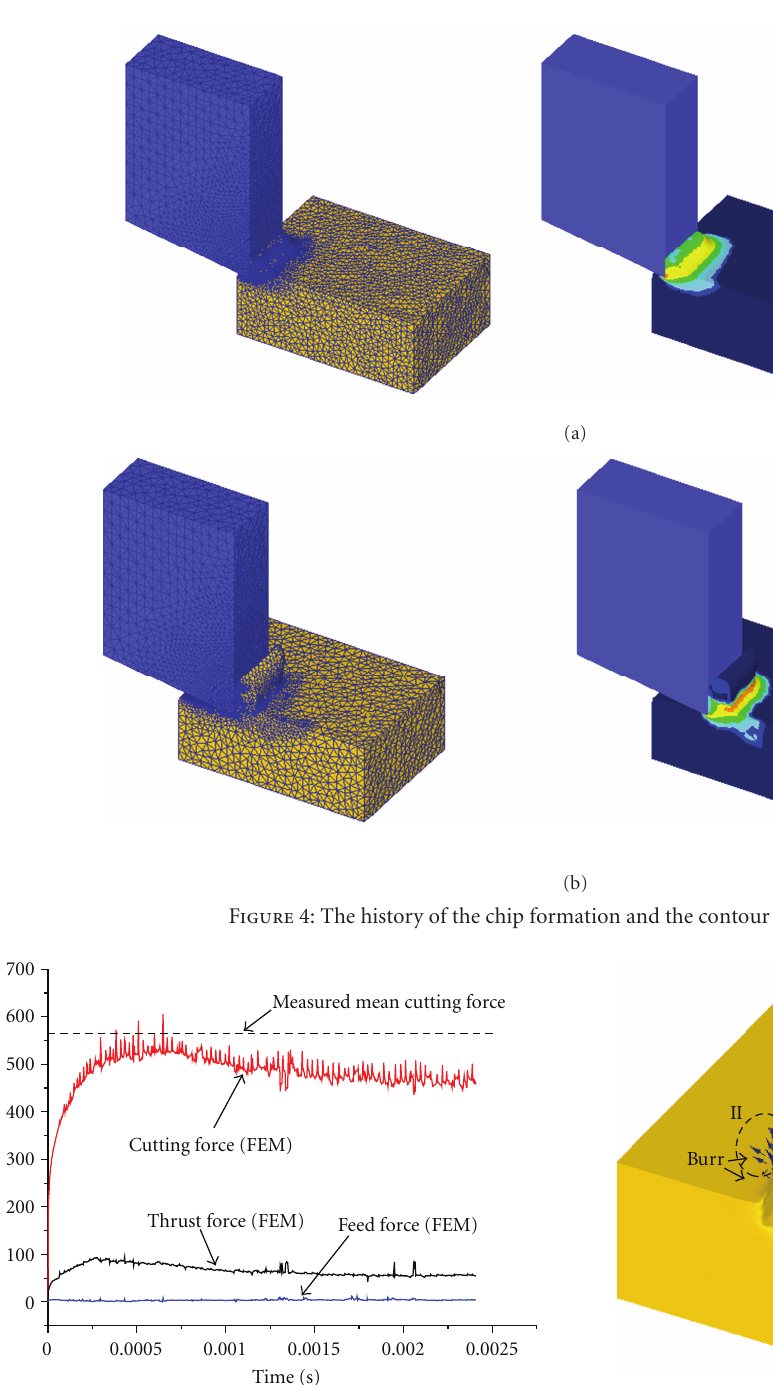
Figure 6: The material flow analysis during the cutting